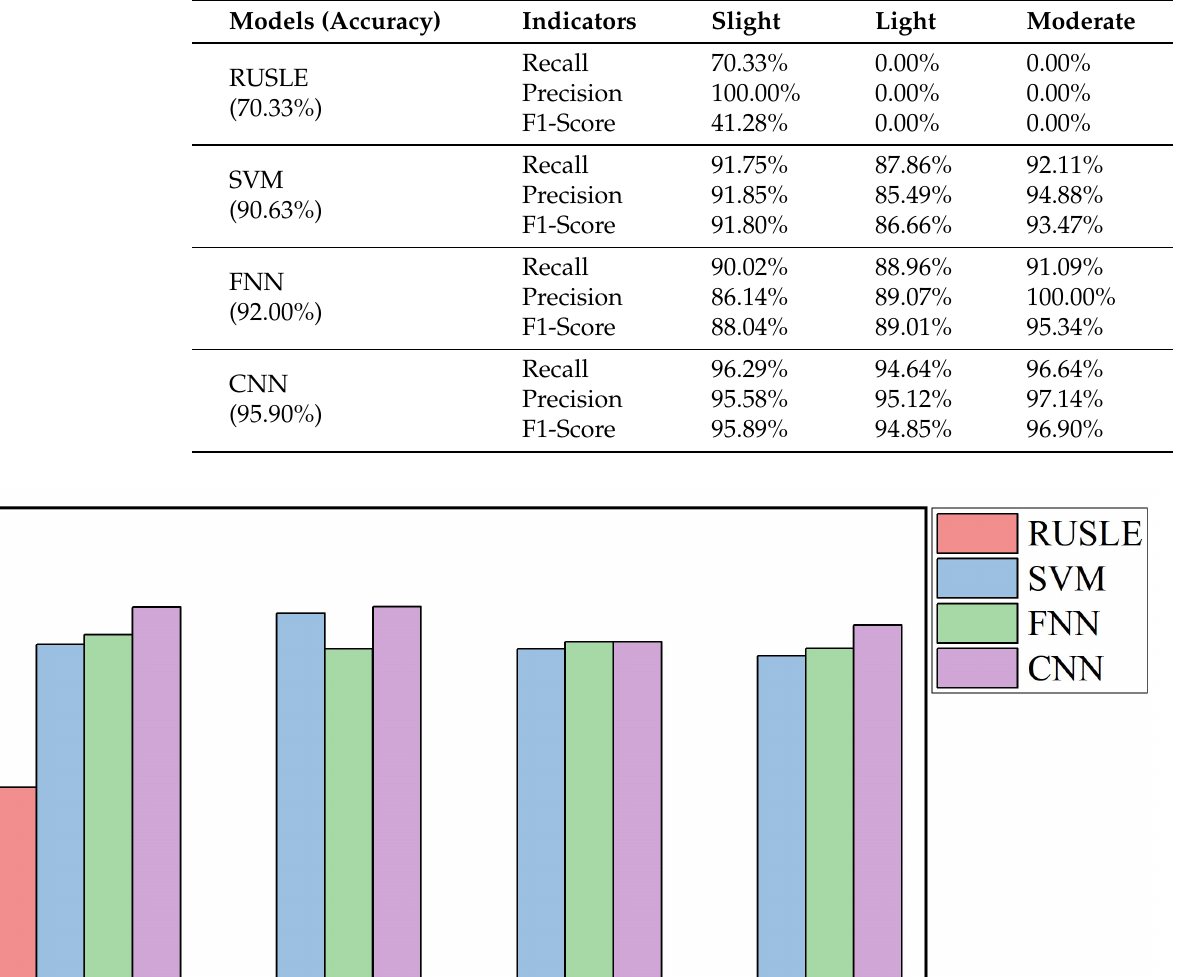
Table 3. Calculation results of model evaluation index.